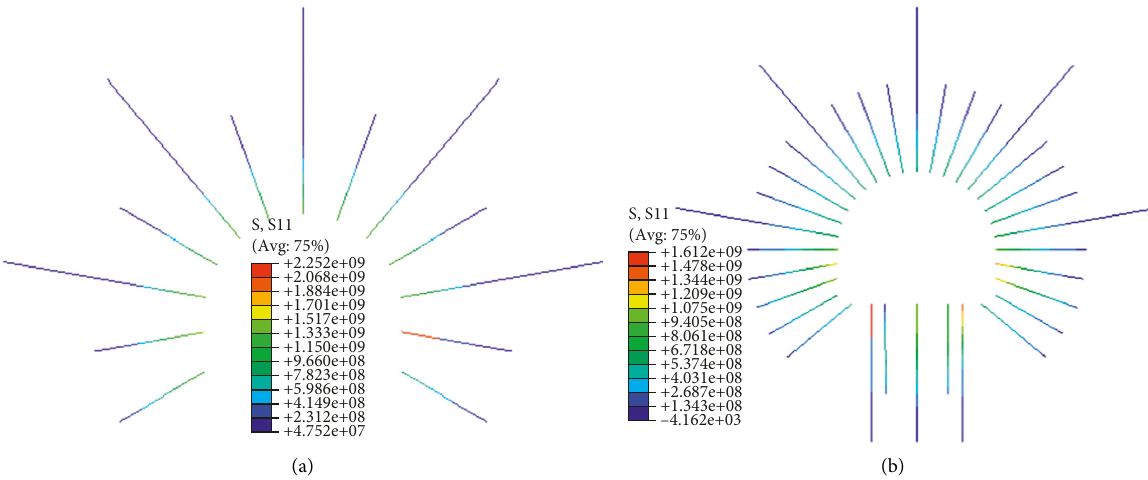
Figure 6: Axial stress clouds of anchor bolts and cables under different conditions (unit: Pa): (a) case 2 and (b) case 3.